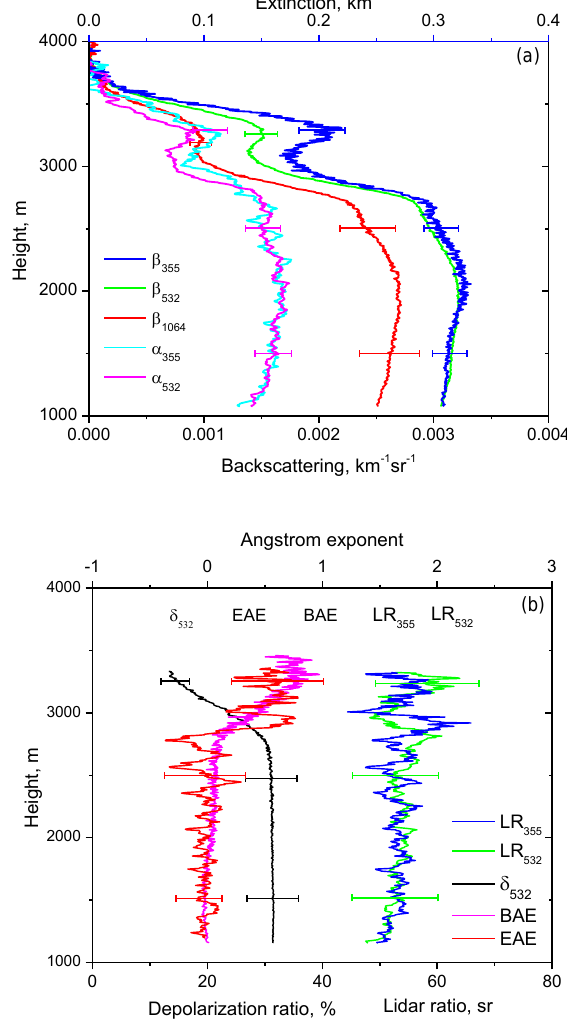
Figure 10. Vertical profiles of (a) backscattering and extinction co- efficients and (b) lidar ratios, depolarization ratio, and backscatter- ing and extinction Ångström exponents at 355/532nm measured on 13 March 2015 for the period of